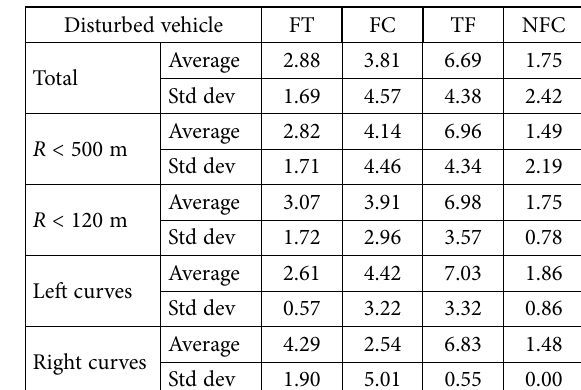
Table 2. Values of the FT, FC, TF and NFC indicators in a ‘disturbed vehicle’ condition